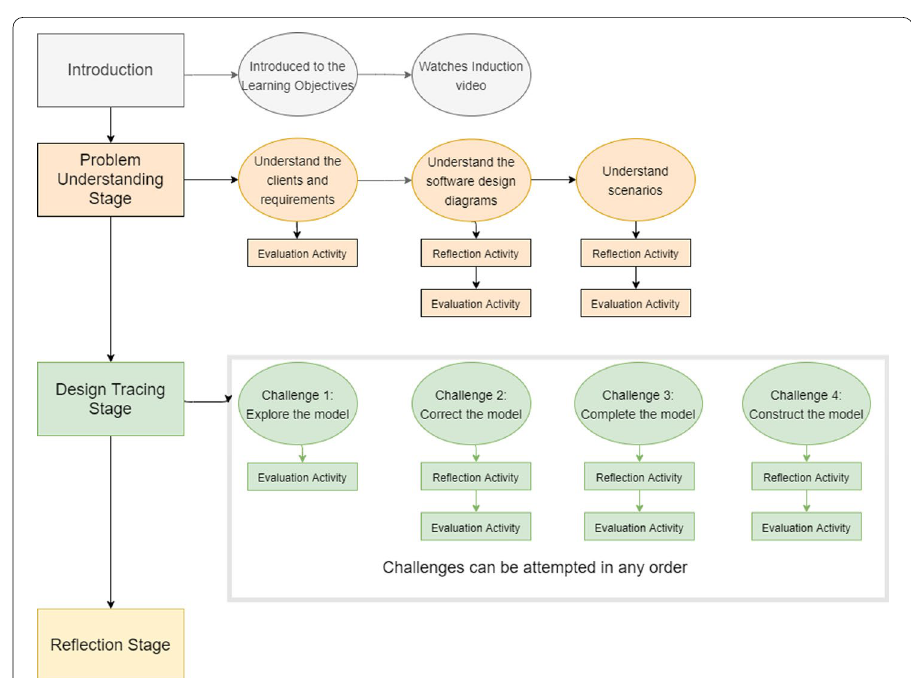
Fig. 4 Overview of learning activities in Module 1 of the